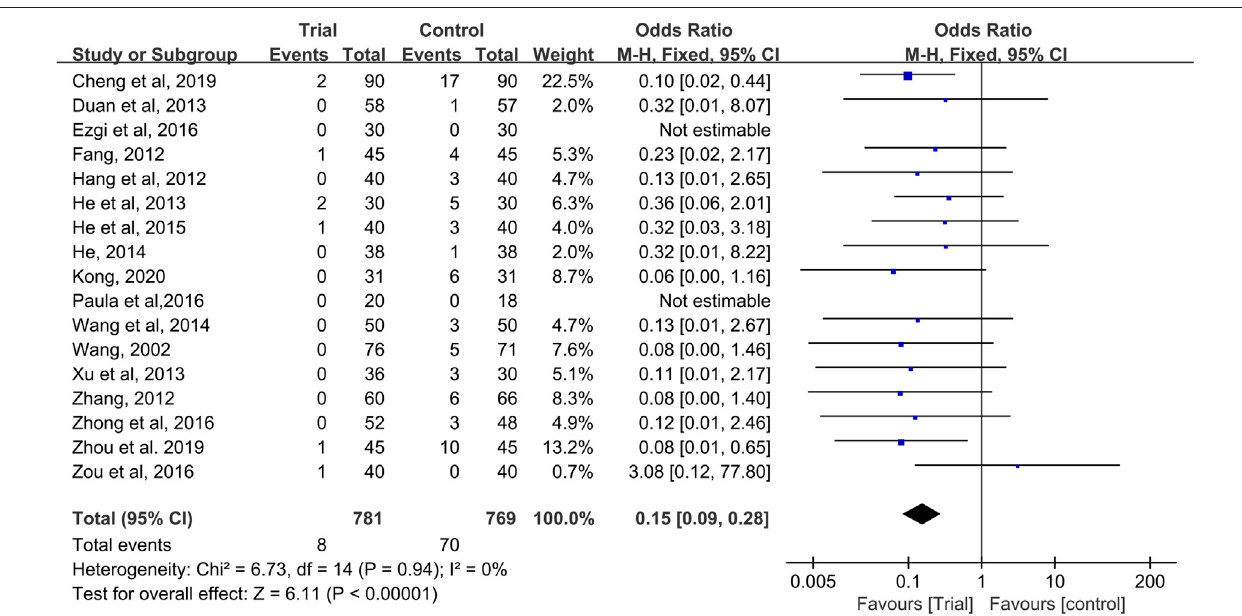
Frontiers in Pharmacology |